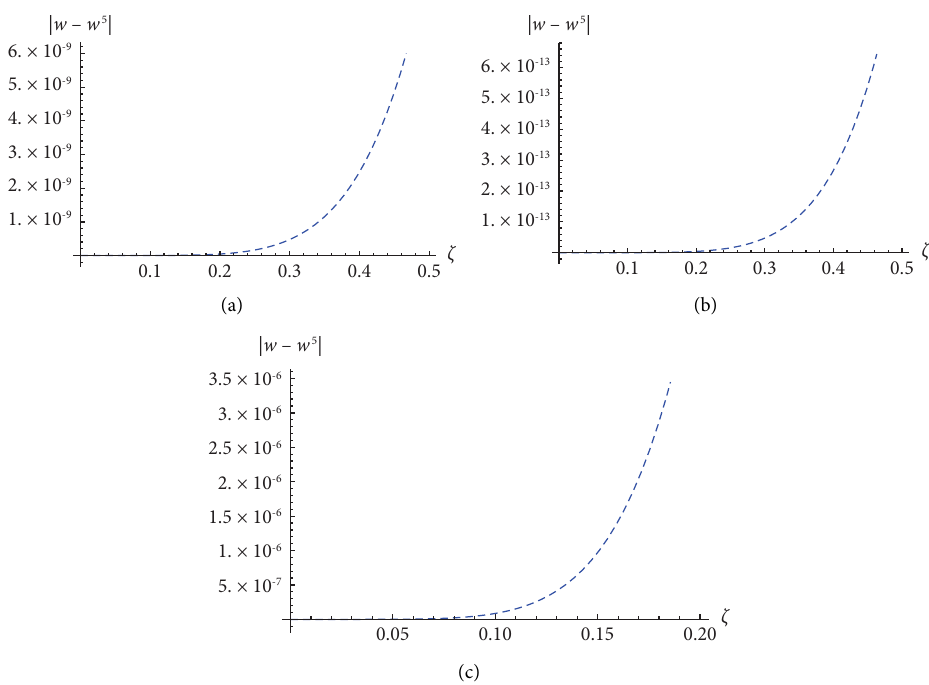
Figure 2: In Figure 2, the 2D curve of | w ( ϰ , ζ ) − w 5 ( ϰ , ζ )| in the range ζ ∈ [ 0 , 0 . 5 ] , when ϖ � 1 . 0 for (a) Problem 1, when ϰ � 0 . 002, (b) Problem 2, when ϰ � 1 . 0, and (c) Problem 3, when ϰ � 1 . 0 and λ � 2 .